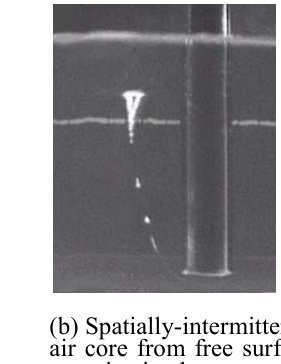
(a) Spatially-continuous air core from free surface to a pipe intake Fig.3 Types of air core, for the judgment of air entrainment.